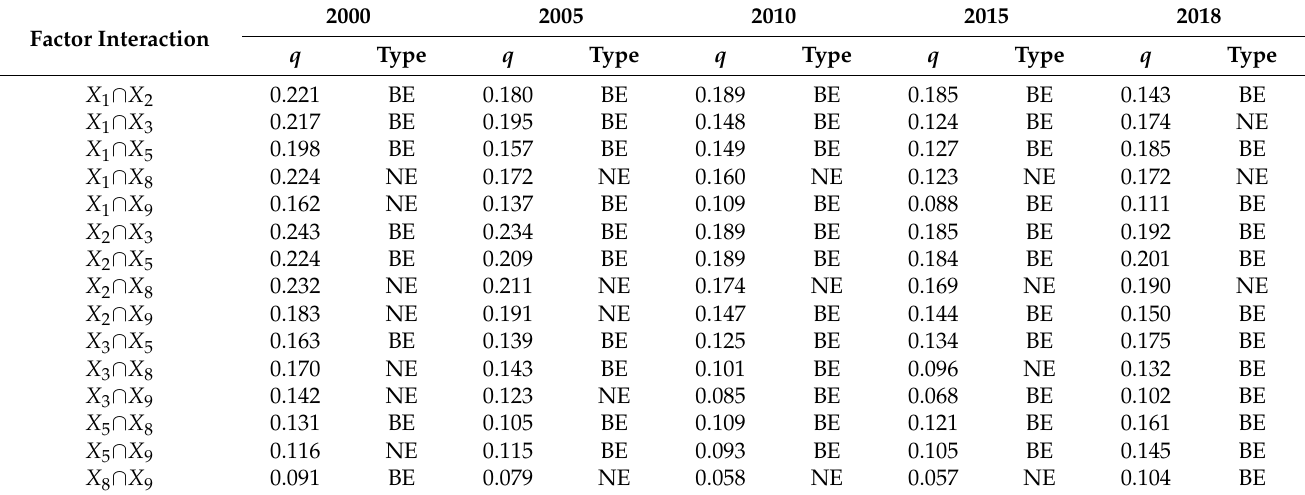
Table 5. Spatial differentiation interactive detection results for non-grain production rate in China.